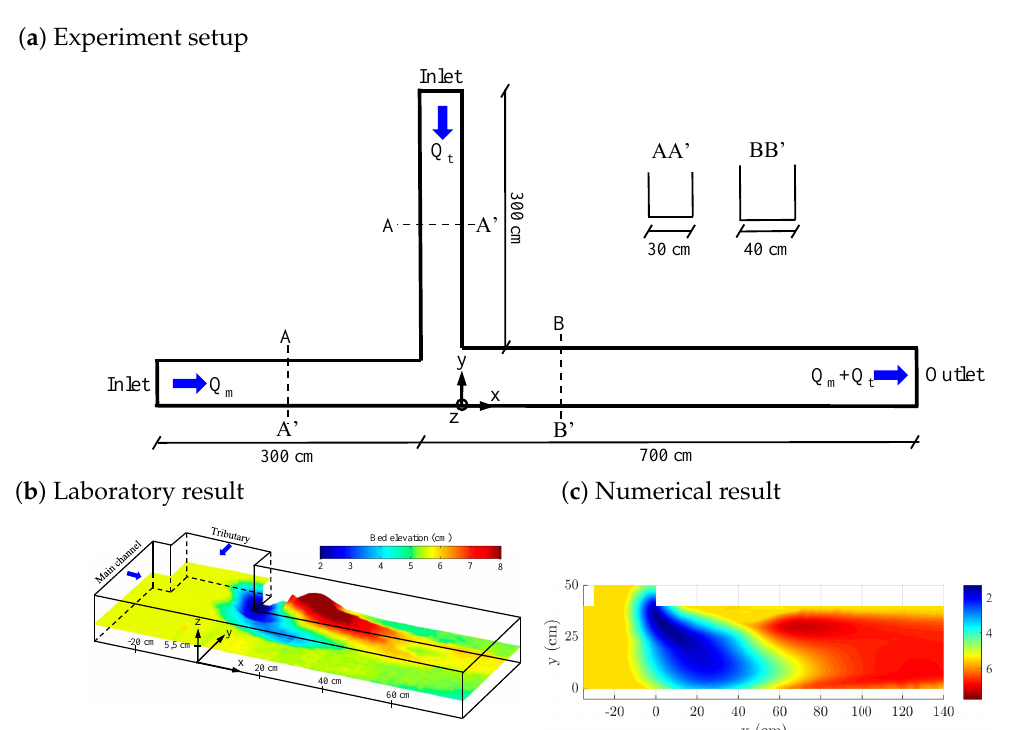
Figure 3. Sketch of bed erosion experiment setup and results. Panel ( a ) depicts the setup. It consists of a perpendicular confluence of rectangular concordant-bed open-channels. The dimensions of the channels are included in the figure. Panel ( b ) depicts a contour of the steady-state bed elevation provided by the laboratory experiment. The initial bed elevation was 5.5 cm. The plot is reproduced from [45]. Panel ( c ) includes the steady-state bed elevation computed with the numerical model. Units are in